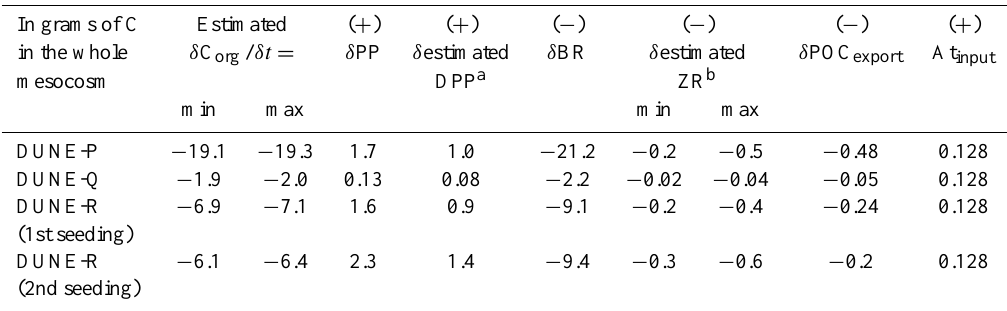
Table 2a. Carbon mass budget. Data result from the integrated carbon fluxes over 7 days for DUST-MESO corrected from the integrated carbon fluxes over 7 days for the CONTROL-MESO. All data are in grams of C in the whole mesocosm. Budget of total organic carbon according to Eq. (2) in the text (Sect. 2).